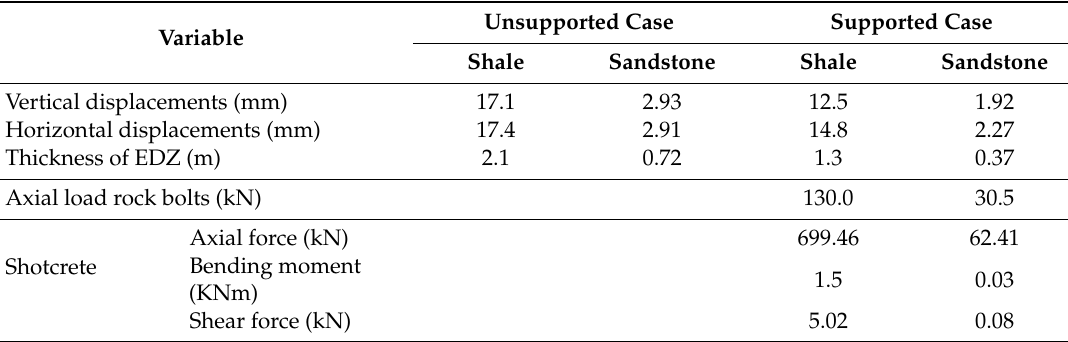
Table 6. Numerical simulations results in transversal tunnels.